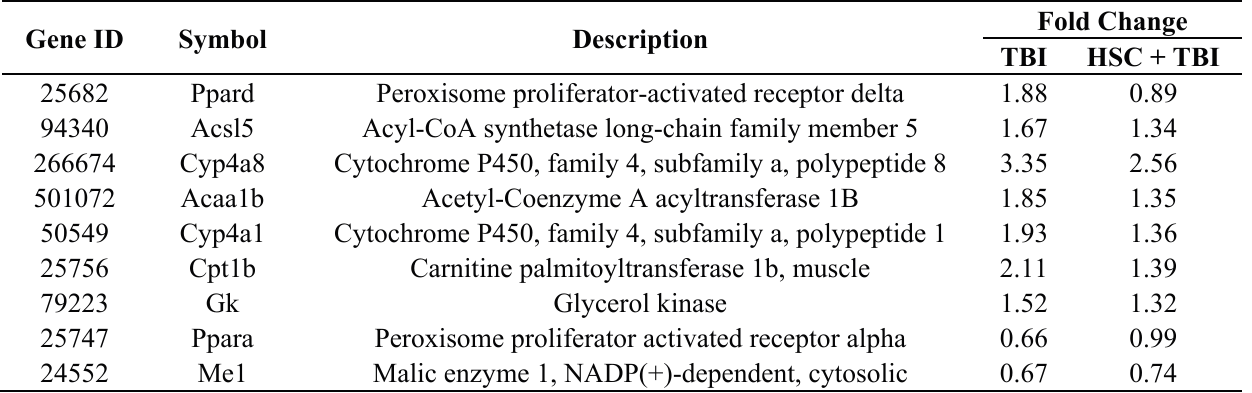
Table 3. The nine genes that were involved in the PPAR signaling pathway.